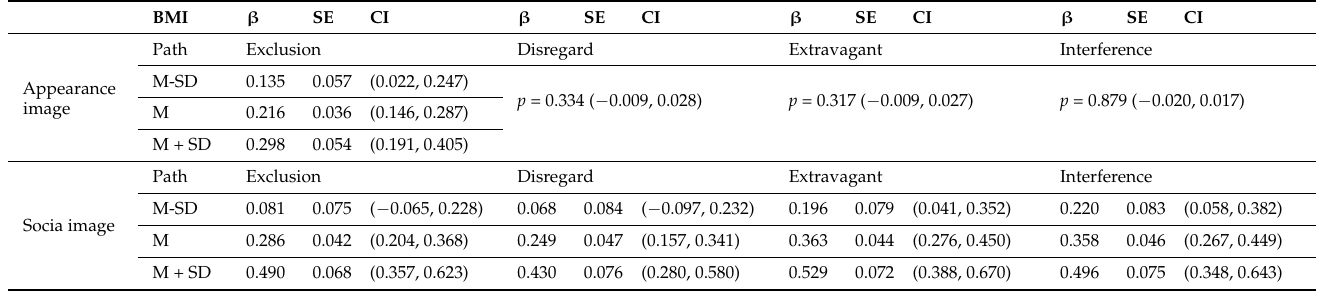
Table A6. Direct effects at different levels of body mass index